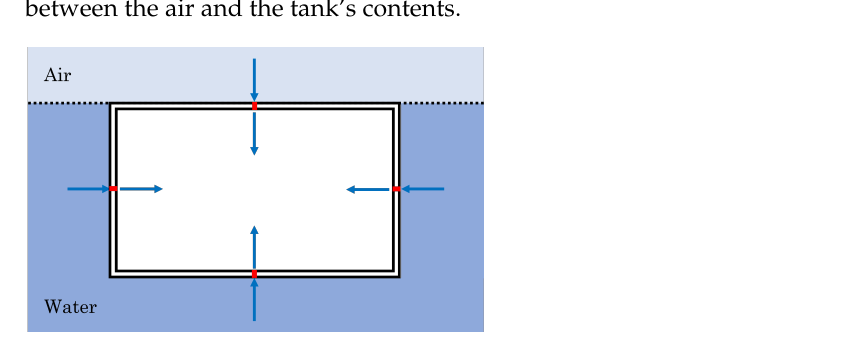
Figure A1. A diagram of a large cuboid tank submerged in water on all sides except the top, which is exposed to air. Heat transfer due to the convection of fluids is denoted using blue arrows and conduction zones are denoted using red patches.